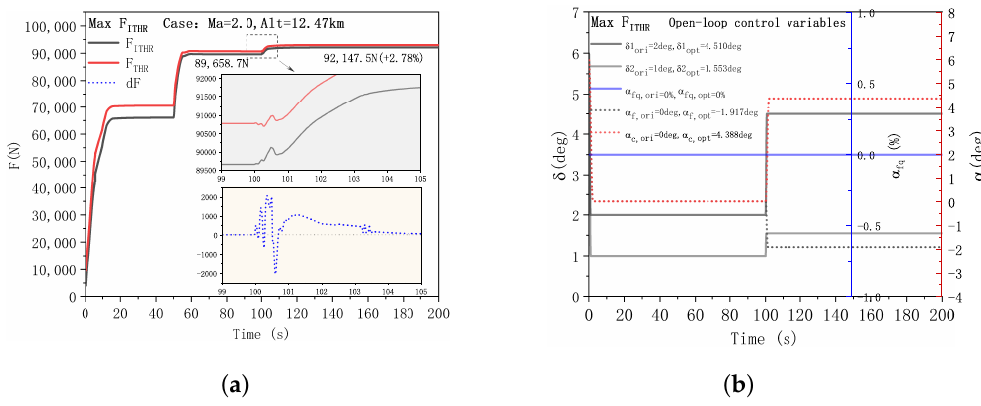
Figure 11. ( a ) Simulation analysis of incorporating PSC Max F ITHR module and ADRC con- troller. ( b ) Dynamic analysis of the open-loop controlled variables α fq , δ 1 , δ 2 , A 8 , α f , α c under Max F ITHR mode.